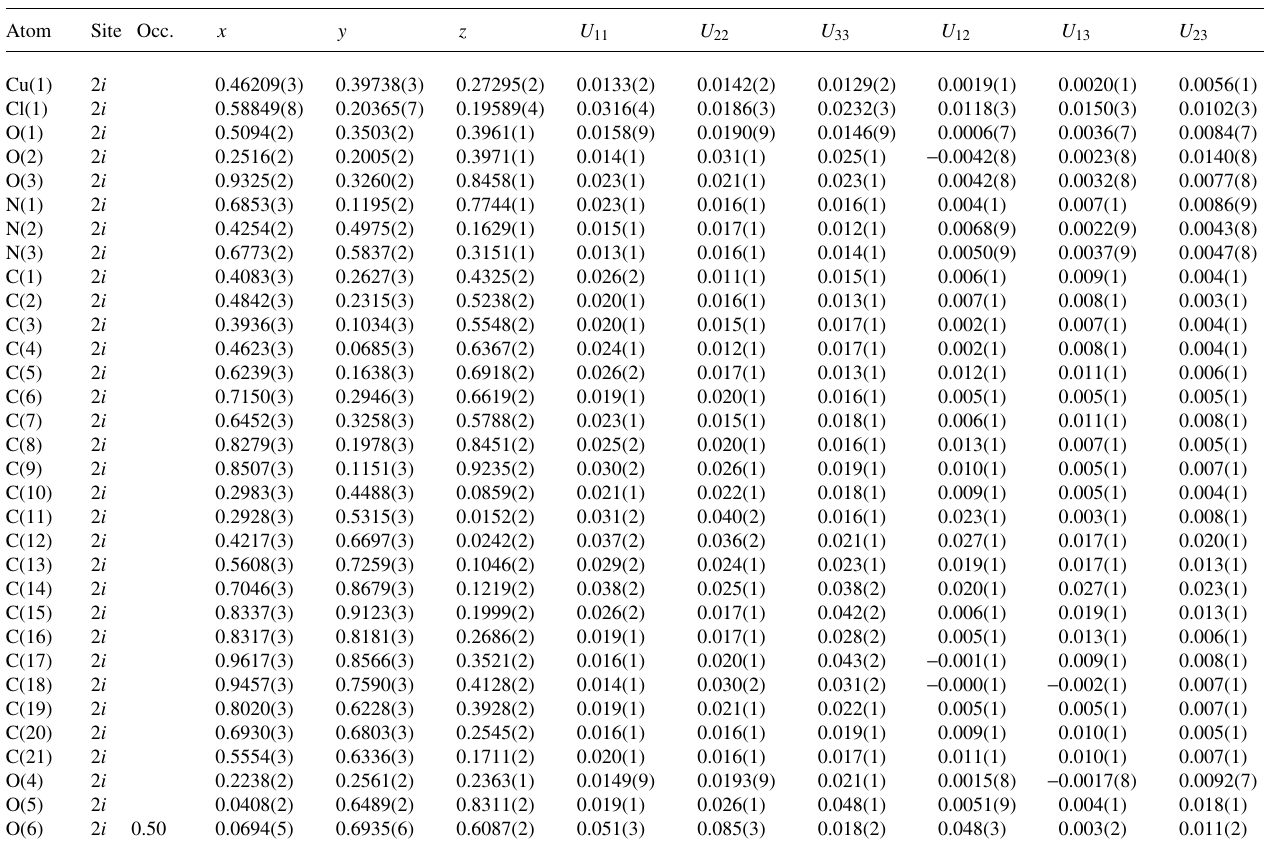
Table 3. Atomic coordinates and displacement parameters (in Å 2 )